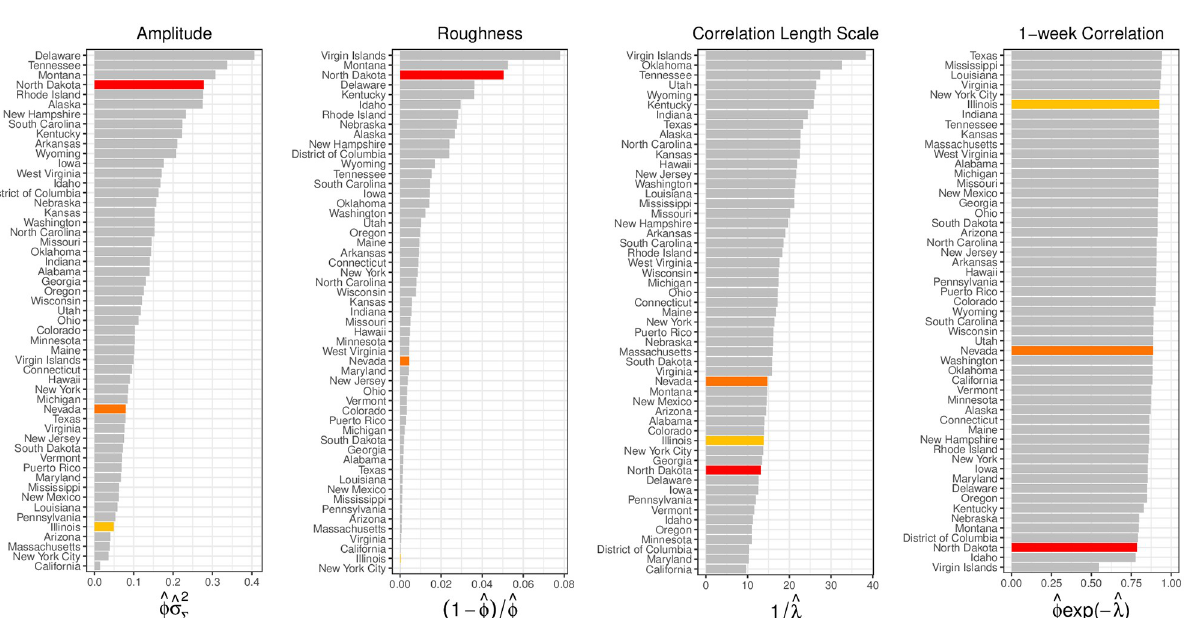
), is rougher (larger ð 1 (cid:0) ^ � Þ = ^ � ), has a similar correlation length scale S